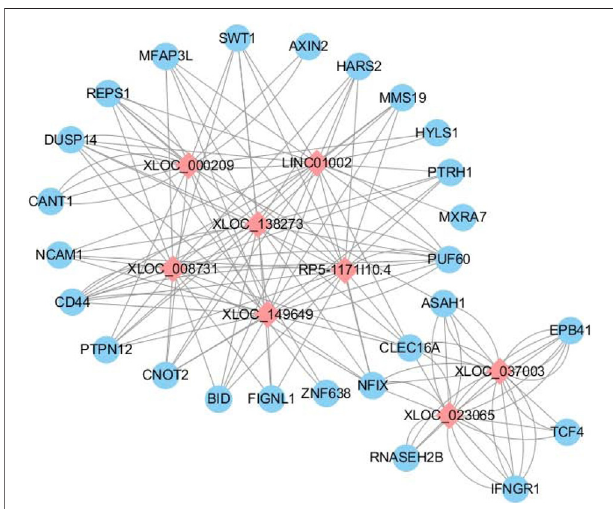
FIGURE 7 | LncRNA – mRNA coexpression network. Differentially expressed lncRNA – mRNA regulatory networks consist of eight lncRNAs and 26 mRNAs. The blue circles represent mRNAs, and the red diamond represents lncRNAs. The Pearson correlation coef fi cient was limited to an absolute value > 0.95 and p -value < 0.001.